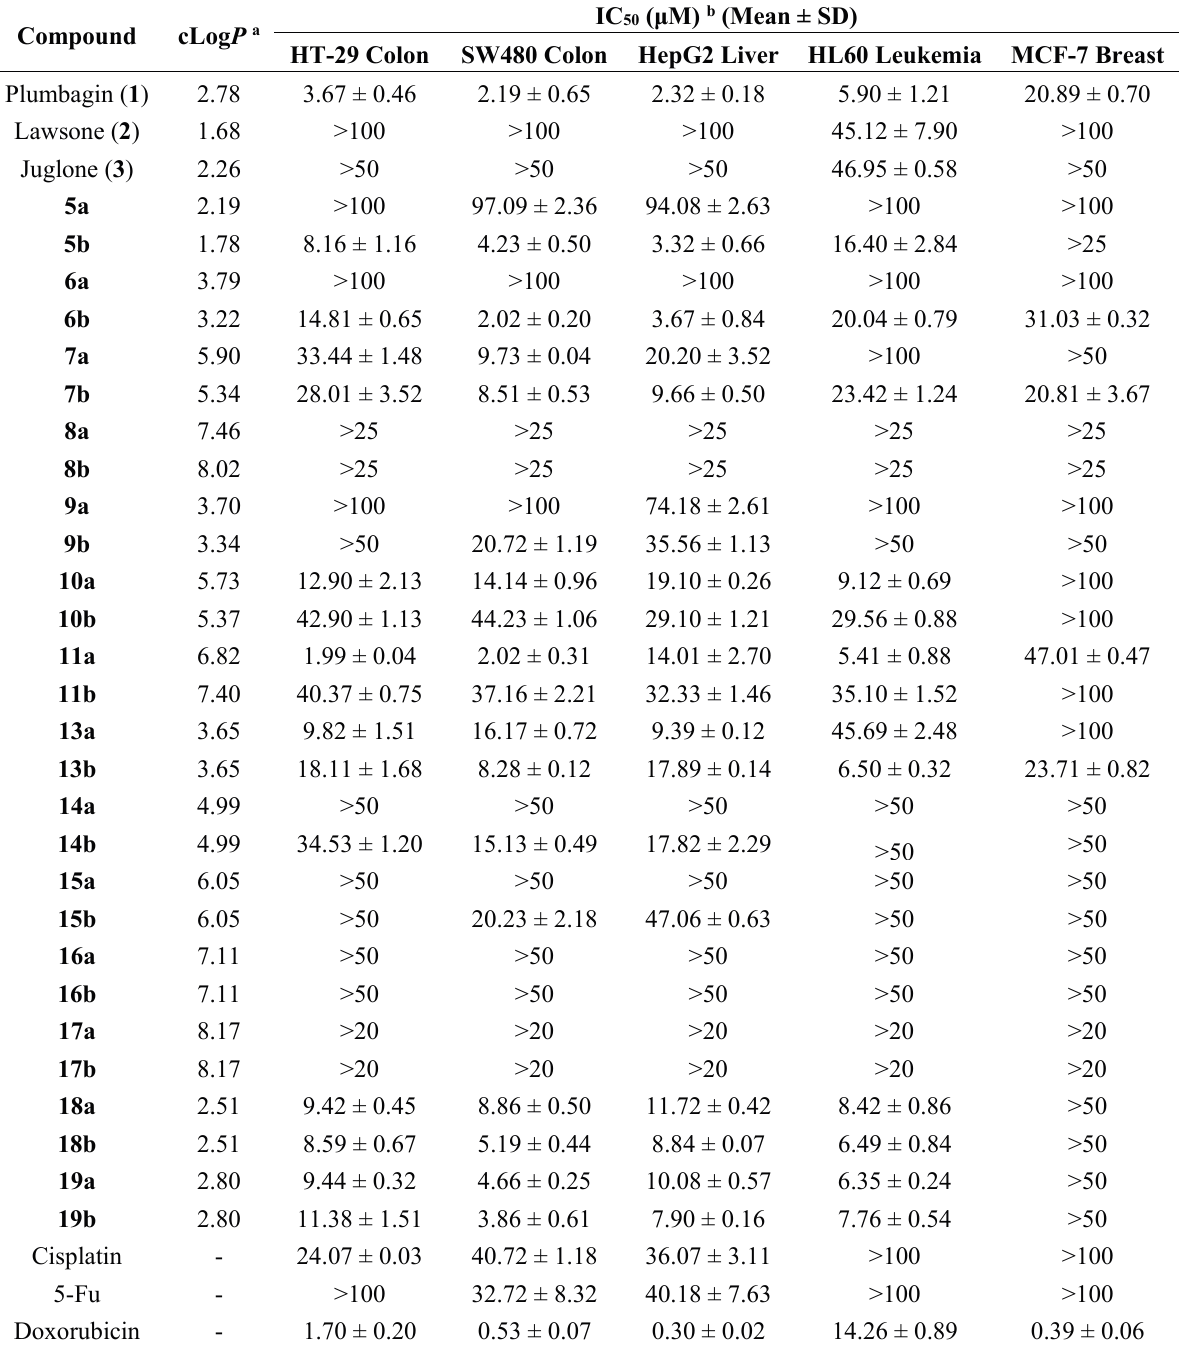
Table 1. IC 50 values of plumbagin ( 1 ), lawsone ( 2 ) and its derivatives 5a , b – 11a , b , 13a , b ‒ 19a , b on the growth of human cancer cell lines for 48 h.